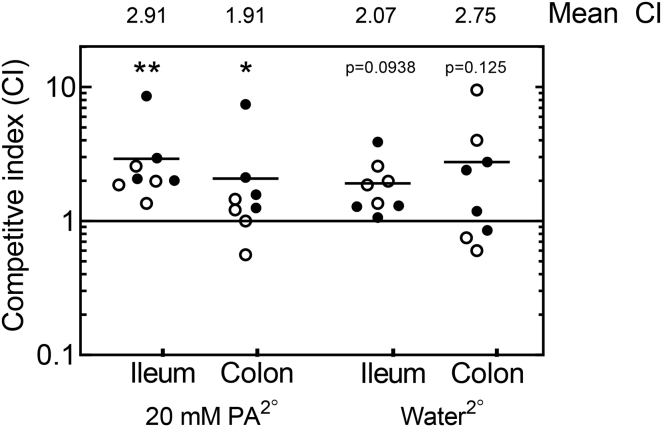
Competitive Index of LF82 from PA-Fed Mice versus LF82 from Water-Fed MiceFor the primary infection (1°), one group of mice (n = 4) were fed 20 mM PA for 3 days prior to challenge. A second group of mice were given only sterile water. A subset of each of these mice were then infected with either LF82 or LF82 carrying a luciferase and erythromycin cassette (LF82lux), and the infection was allowed to proceed for 7 days. This resulted in the recovery of strains labeled LF82-PA1°, LF82-W1°, LF82lux-PA1°, and LF82lux-W1° from ileal and colonic homogenates. Bacteria were isolated using LB supplemented with either ampicillin or erythromycin. Subsequently, equal quantities of LF82-PA1° and LF82lux-W1° were mixed, as were LF82lux-PA1° and LF82-W1°, giving final concentrations of 1 × 109 CFU mL−1 (0.5 × 109 CFU mL−1 of each strain). The ratios of LF82-PA1°:LF82lux-W1° and LF82lux-PA1°:LF82-W1° were determined by plating on LB plates supplemented with ampicillin or erythromycin. Mice were again given either 20 mM PA or sterile drinking water for 3 days prior to challenge, before infection with either LF82-PA1°:LF82lux-W1° or LF82lux-PA1°:LF82-W1°. Seven days post-infection, bacteria were recovered by plating ileal and colonic homogenates on either ampicillin or erythromycin. Competitive indices (CI) were determined by normalization to the initial inoculum ratios. Black circles represent LF82-PA1°, whereas white circles represent LF82lux-PA1°. The solid black line at CI = 1 represents LF82-W1° and LF82lux-W1°. Statistical analyses for each dataset were conducted using the individual colony counts. A two-tailed Wilcoxon rank-sum test was conducted (∗p < 0.05 was deemed significant).